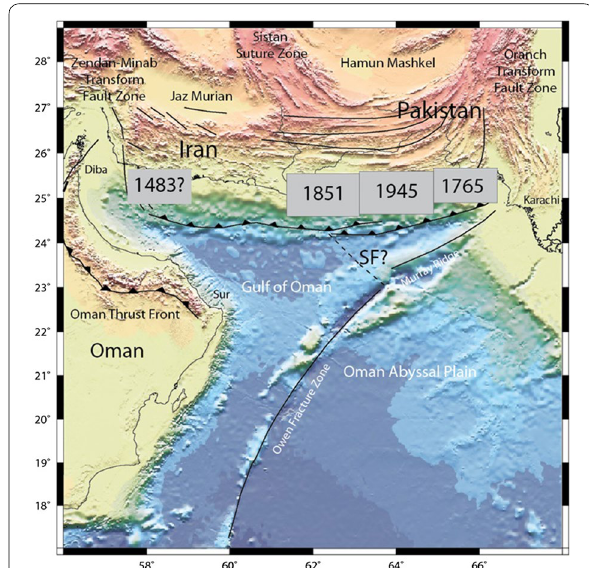
Fig. 1 Main structural setting of the Makran Subduction Zone area. Ruptured area of strong historical earthquakes in Makran based on Byrne et al. (1992) and Okal and Synolakis (2008). SF: Sonne Fault, defining a small microplate boundary, called Ormara microplate by Kukowski et al.